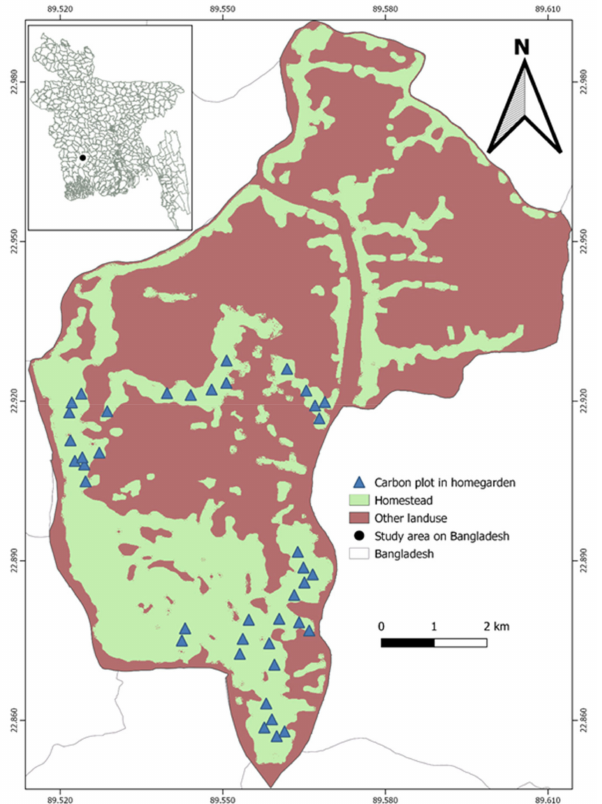
Figure 1. Location carbon plots within homesteads in Dighalia Upazila, Khulna,